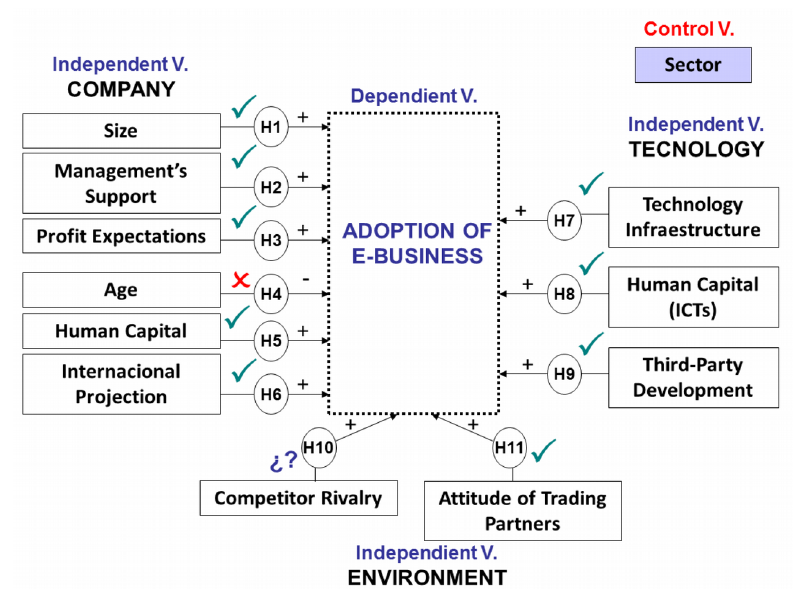
Figure 2. Hypothesis